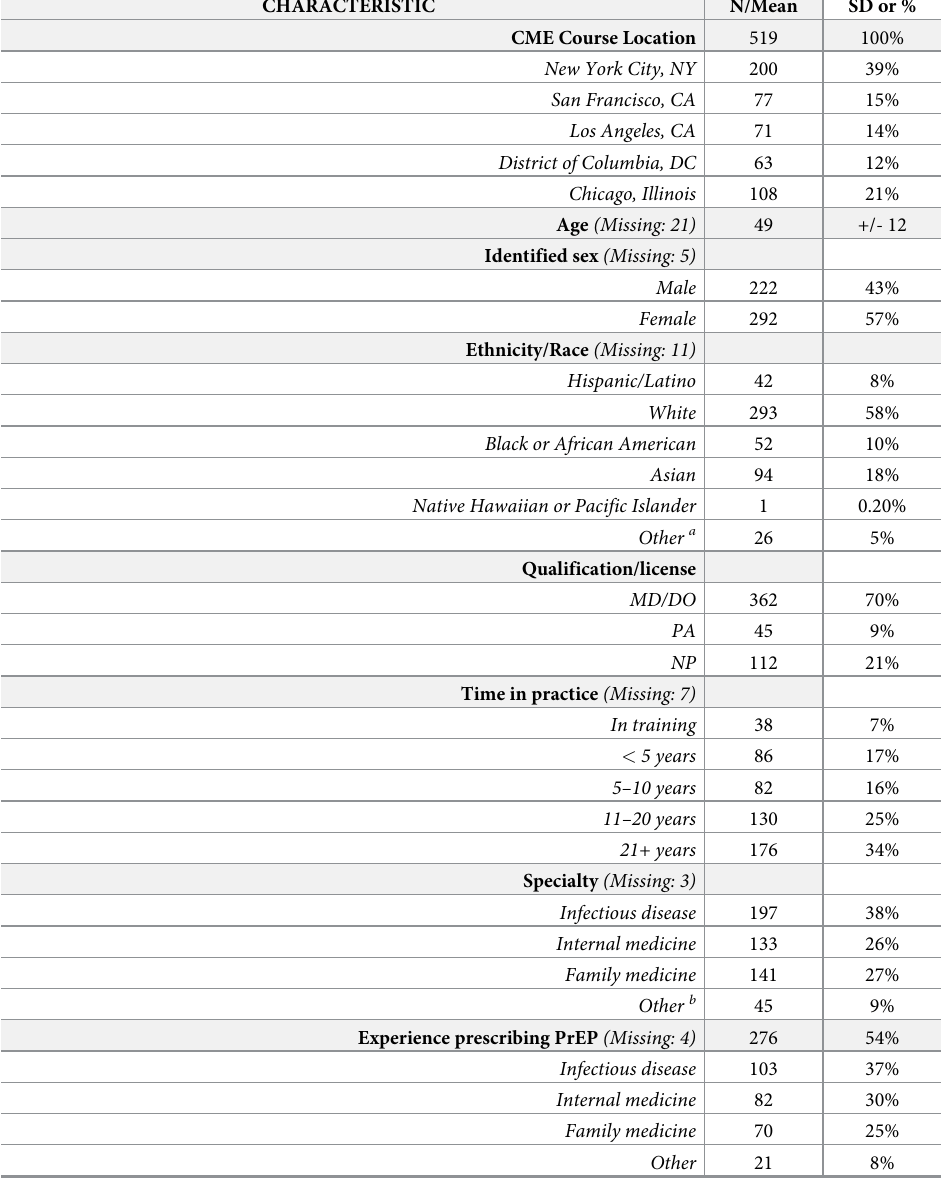
Table 1. Demographic and prescribing